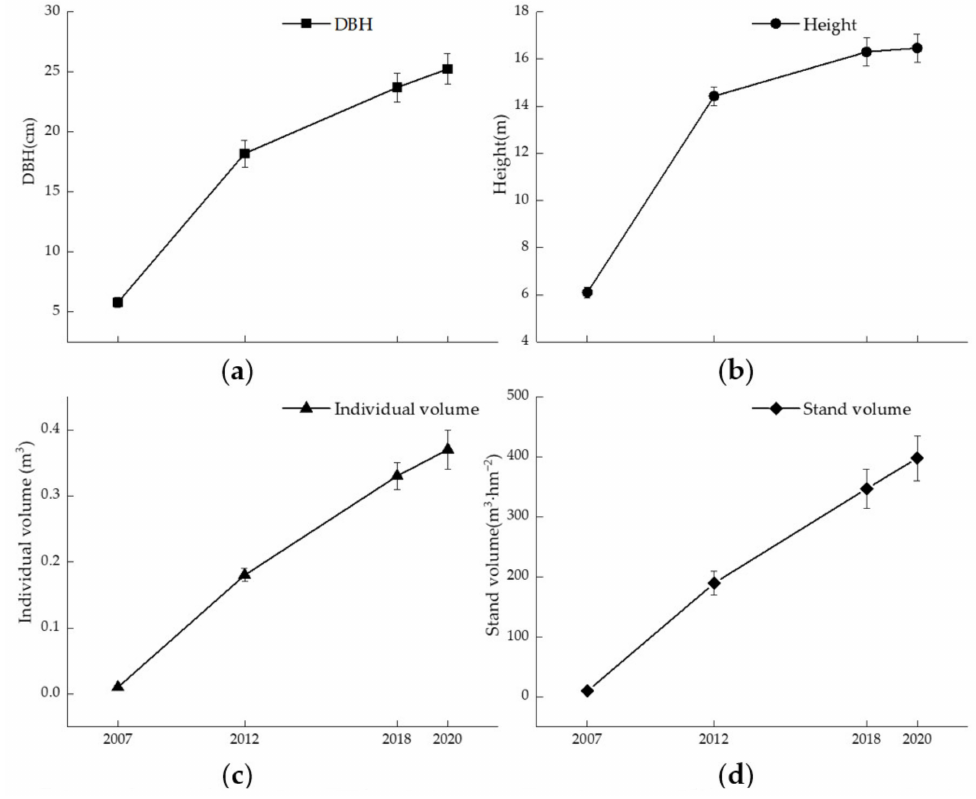
Figure 2. The growth of Populus tomentosa clone S86 in 2007, 2012, 2018, and 2020. Data are the mean ± standard deviation. ( a – d ) describe the DBH, height, individual volume, and volume,